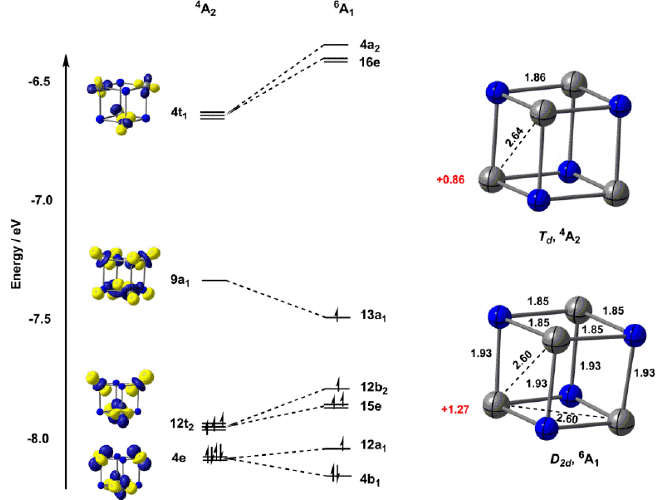
Figure 2. Optimised structures (TPSS / def2-TZVP) and Kohn–Sham molecular orbital diagrams for the quartet ( 4 A 2 ) and sextet ( 6 A 1 ) states of [V 4 N 4 ] + . Bond lengths (in Å ) are shown in black, Mulliken spin densities are shown in red. The levels of the 6 A 1 state have been shifted upwards by 0.59 eV to bring the barycentre of the 12a 1 – 4b 1 pair into coincidence with the 4e level of 4 A 2 .